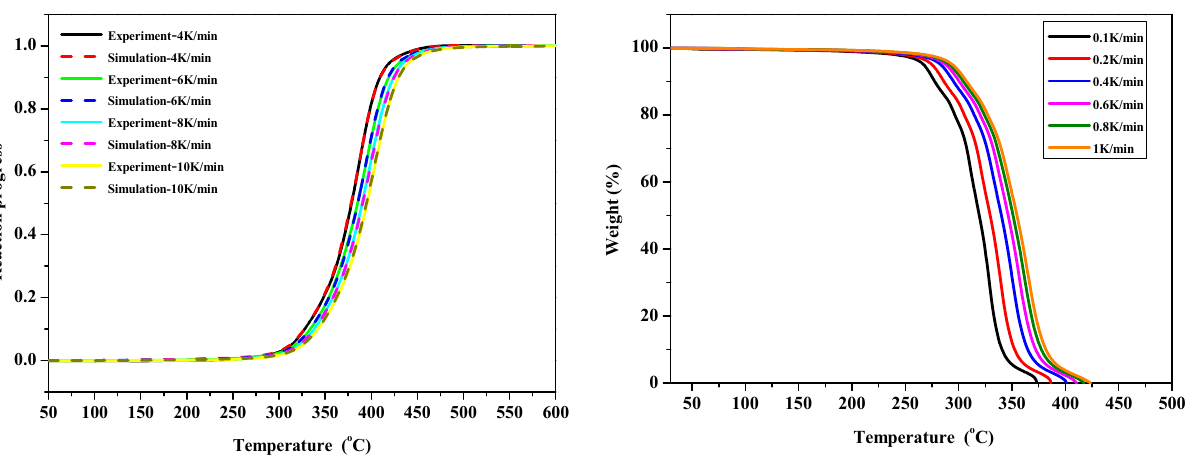
Figure 7: TG curves of polyacrylate PSA at di ff erent slow heating rates.